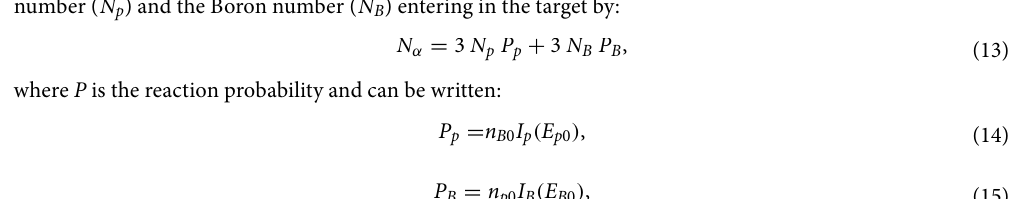
Figure 9. Proton phase spaces at ( a , b ) t cycle laser pulse. ( b – d – f ) with a 10–cycle laser